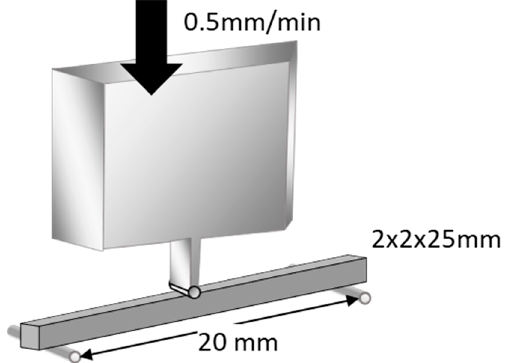
Figure 1. Schematic illustration of flexural strength test. Flexural strength was measured using a three-point-bending technique with a 20 mm span and a crosshead speed of 0.5 mm/min (reproduced with permission from Maruo Y. et al. Acta Odontol. Scand. 2015 [24]).